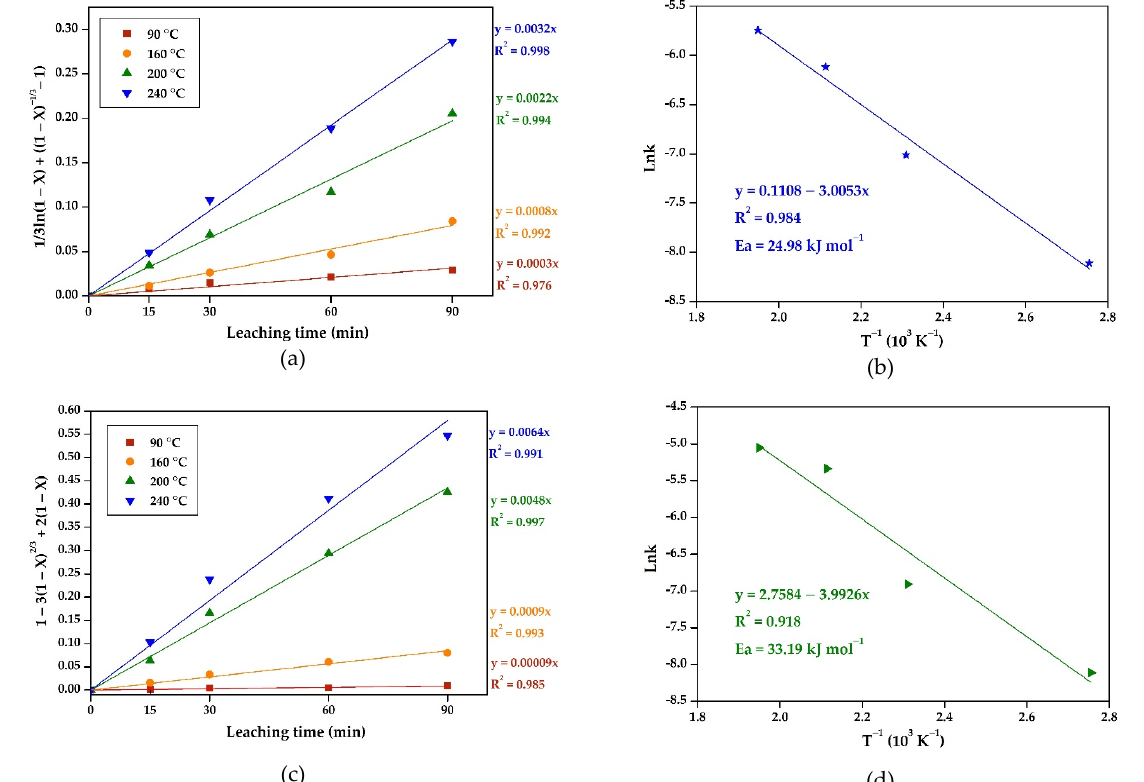
Figure 7. Results of substituting the data for ESPD leaching to Equation (3) ( a ); substituting the data for ESPDW leaching to Equation (2) ( c ); dependence ln k − T − 1 for leaching the original ESP dust ( b ) and water-treated ESP dust ( d ).